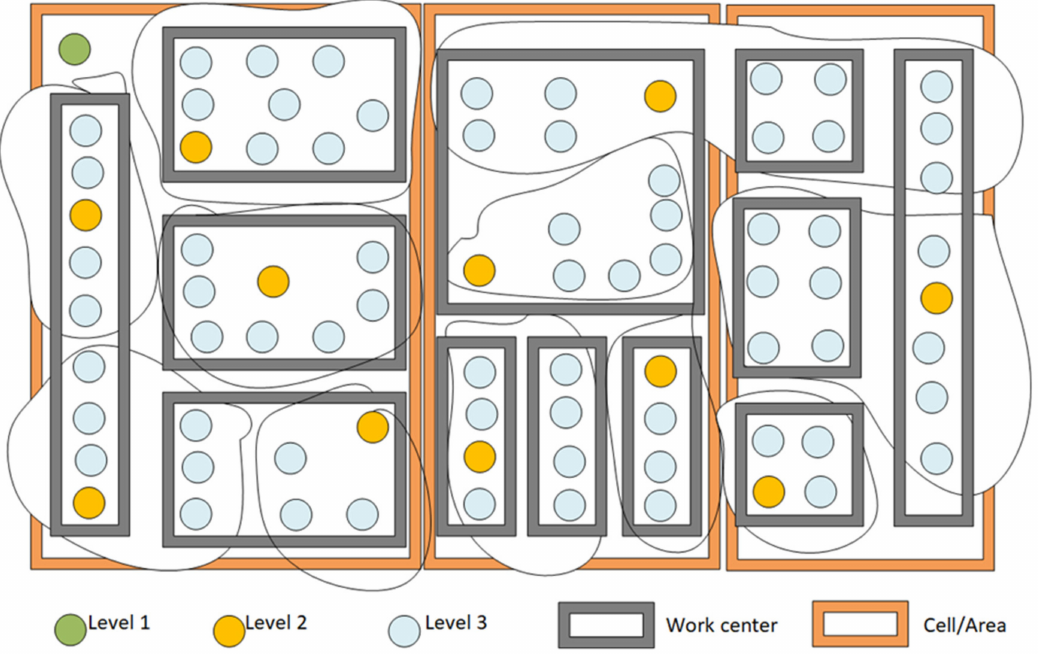
Figure 8. Client update distribution across the factory